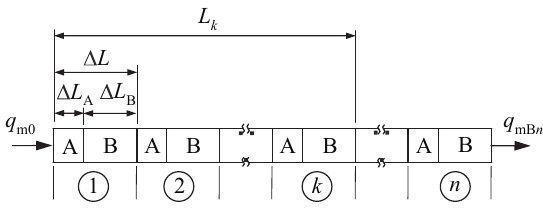
Fig. 2 A model of a particle charging control system made of two different materials, A and